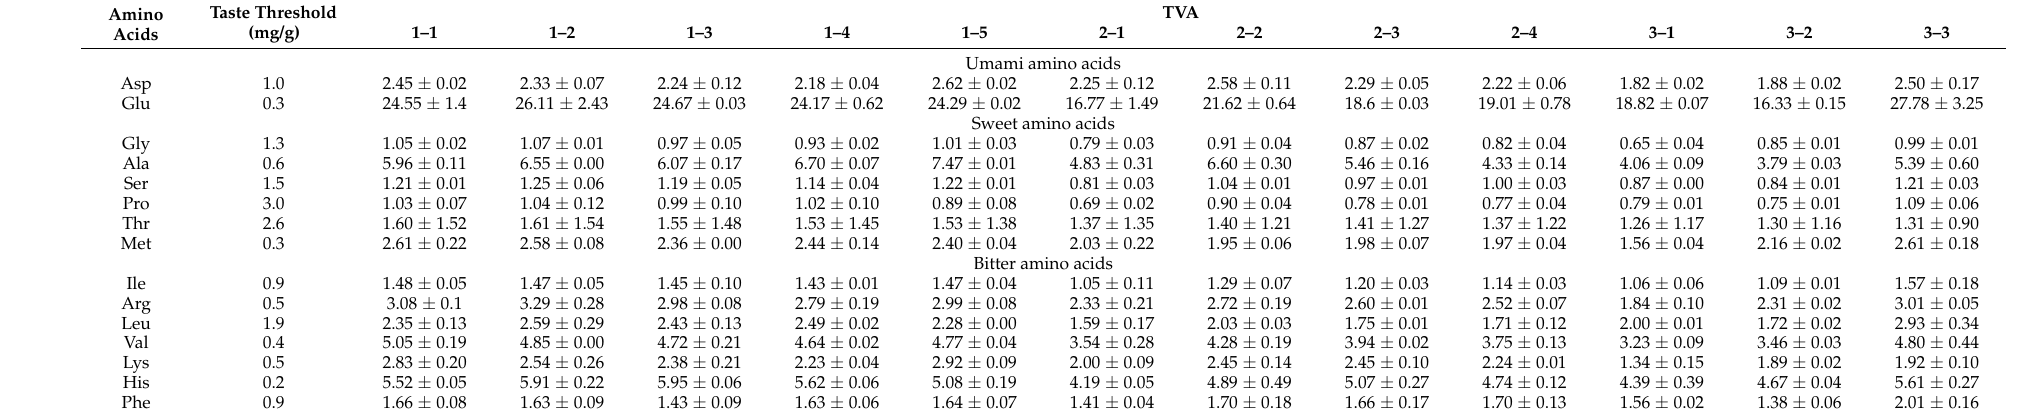
Table 14. Taste threshold ratios of flavor amino